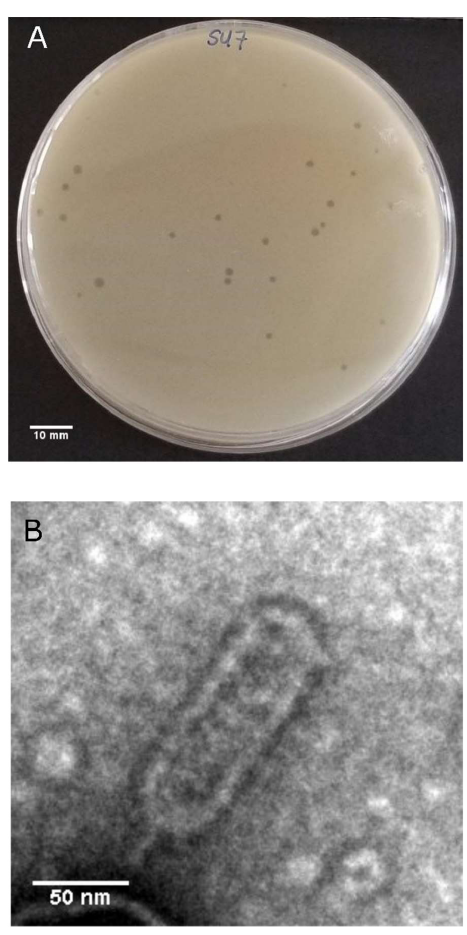
Figure 1. ( A ) Plaque morphology of SU7. Phages were cultured on ETEC7 forming 1 mm clear transparent plaques (1.4 ± 0.3 mm in diameter). ( B ) Transmission electron microscope micrograph of negatively stained phage SU7 at 13,000× magnification. SU7 has an elongated head with a length of 134 nm (134 ± 6 nm) and a width of 44 nm (44 ± 2 nm).